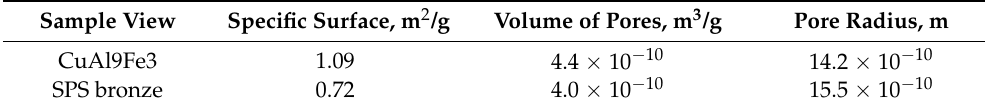
Table 3. Specific surface and porosity of the electrode materials.